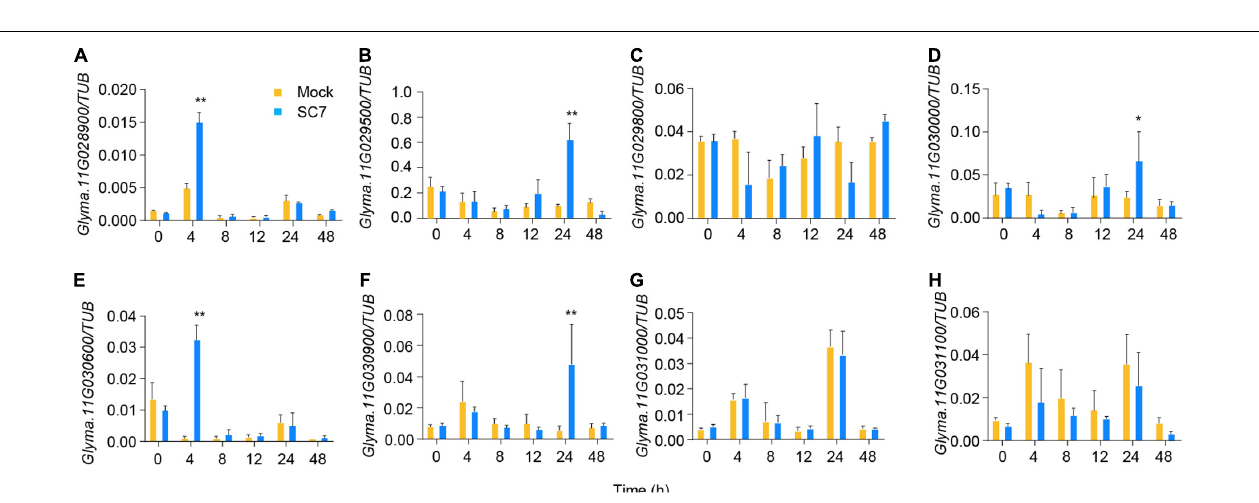
FIGURE 6 | Expression analysis of eight candidate genes in leaves after SC7 inoculation. Values are mean ± s.e.m. ( n = 3 biologically independent samples). A Student’s t -test was used to generate the P -values. * P < 0.05; ** P < 0.01. Orange boxes represent mock treatment and blue boxes represent treat with SC7 stain in (A–H) ,